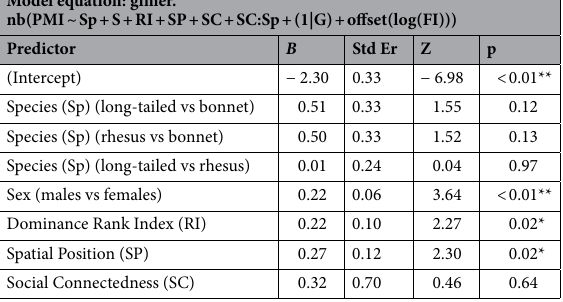
Table 5. Best-fit GLMM examining the impact of macaque attributes on the proportion of macaque-initiated human–macaque interactions (PMI). Group (G) was a random effect, and the frequency of human–macaque interactions (FI) was an offset variable. **p < 0.01; *p < 0.05.